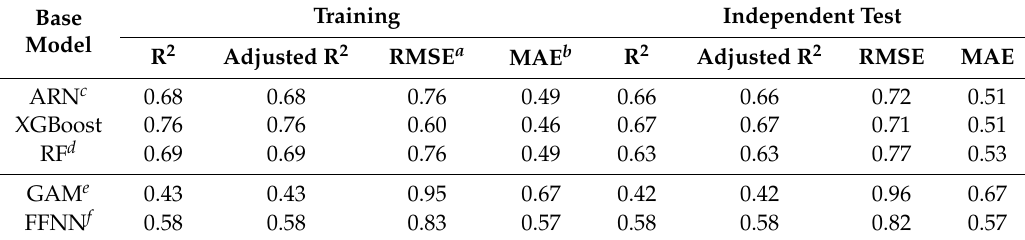
Table 2. Performances of individual models.